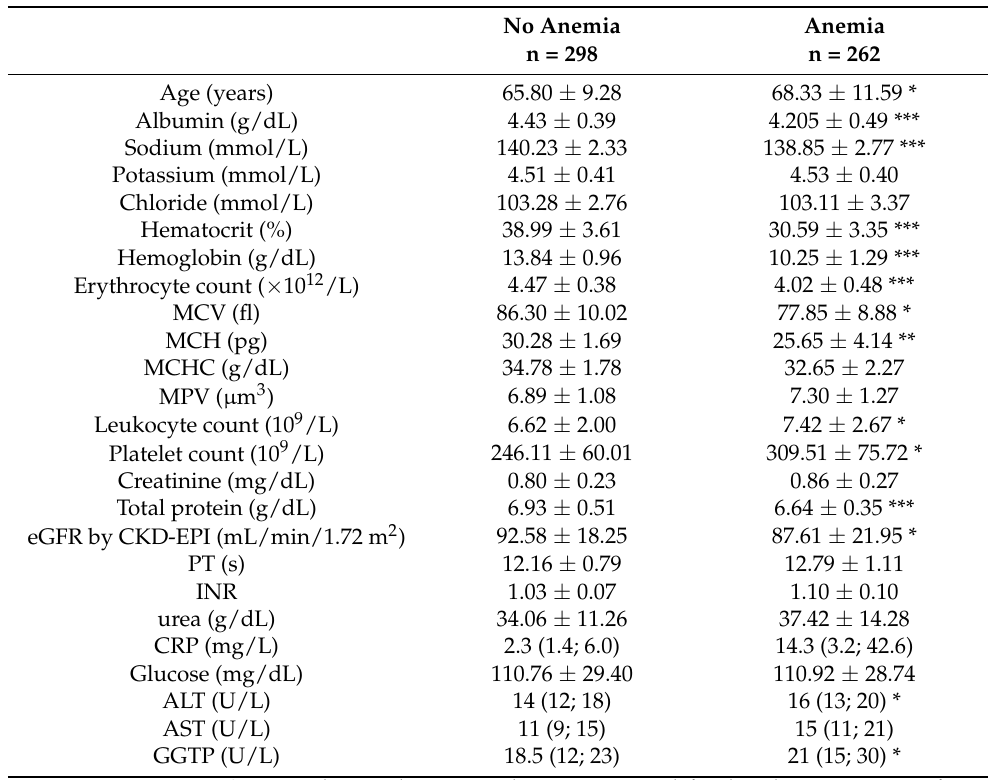
Table 4. Clinical and biochemical data of colorectal cancer patients in regard to presence or absence of